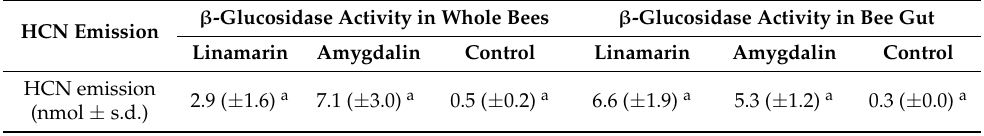
Table 1. β -glucosidase activity in whole bees and bee gut determined by measuring hydrogen cyanide (HCN) emission from homogenized whole bees and bee gut with nothing (control), linamarin or amygdalin added (average total nmol HCN emitted during incubation for each sample ( ± standard deviation)). Whole bees ( n = 10) and bee guts ( n = 10) were tested in two different